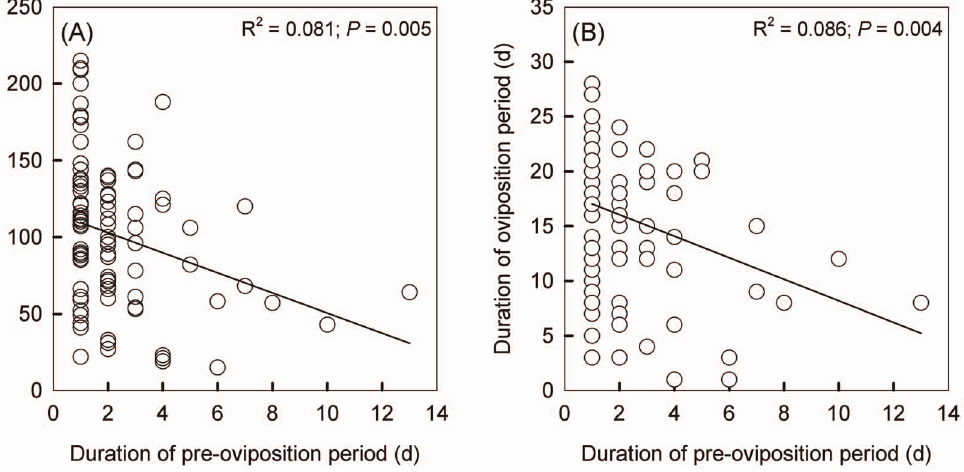
Fig. 4. Relationships between pre-oviposition period and lifetime fecundity or oviposition period. The linear regression analysis showed that delayed oviposition after heat exposures had minor impacts on the lifetime fecundity (y 5 116–6.5x, R 2 5 0.081, P 5 0.005) and duration of oviposition period (y 5 18.0– 1.0x, R 2 5 0.086, P 5